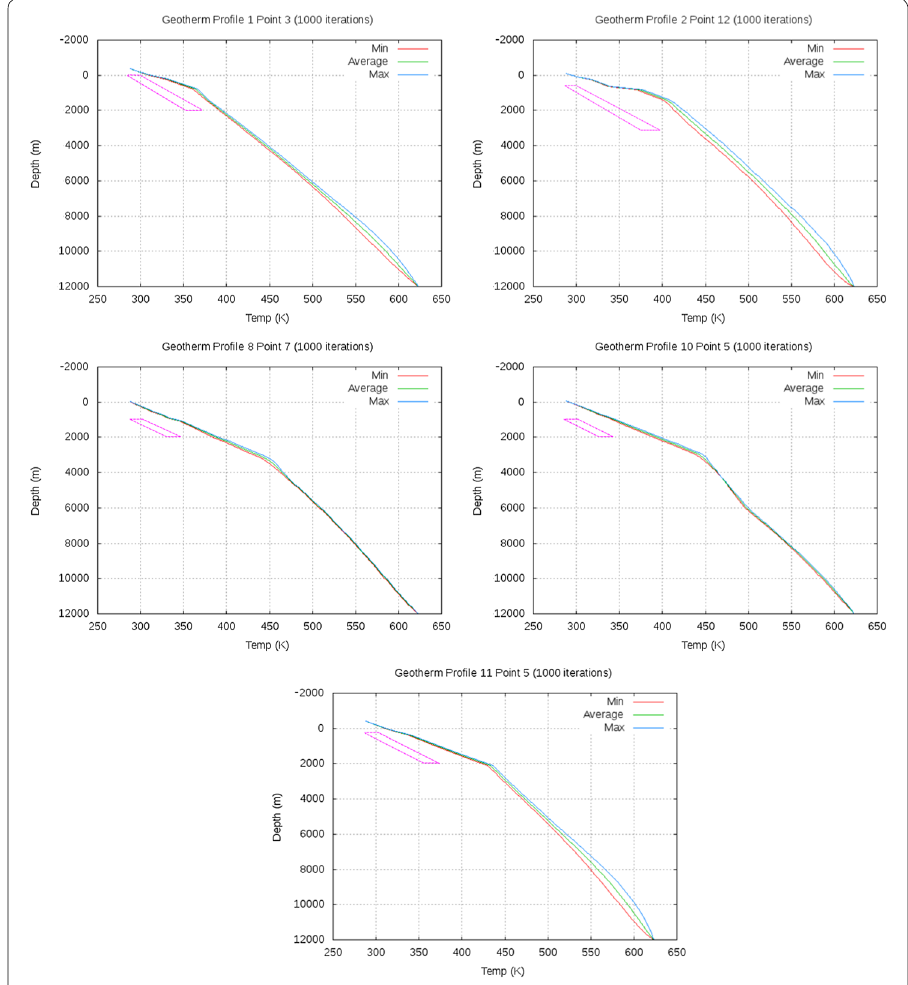
Fig. 12 Geothermal plot comparison between temperature-dependent thermal model and extrapolated temperature range untaken by Danis et al. (2012) shown by the purple outline. The temperatures reported by Danis et al. (2012) are based on measured equilibrated temperatures at specific borehole locations. Our models show the effect of coal measures on the local geothermal gradient, but are not able to replicate the same measured temperatures reported by Danis et al. (2012). The large-scale blanketing effect of coal seams result in a net increase in modelled temperatures at depth, despite both models starting at the same surface